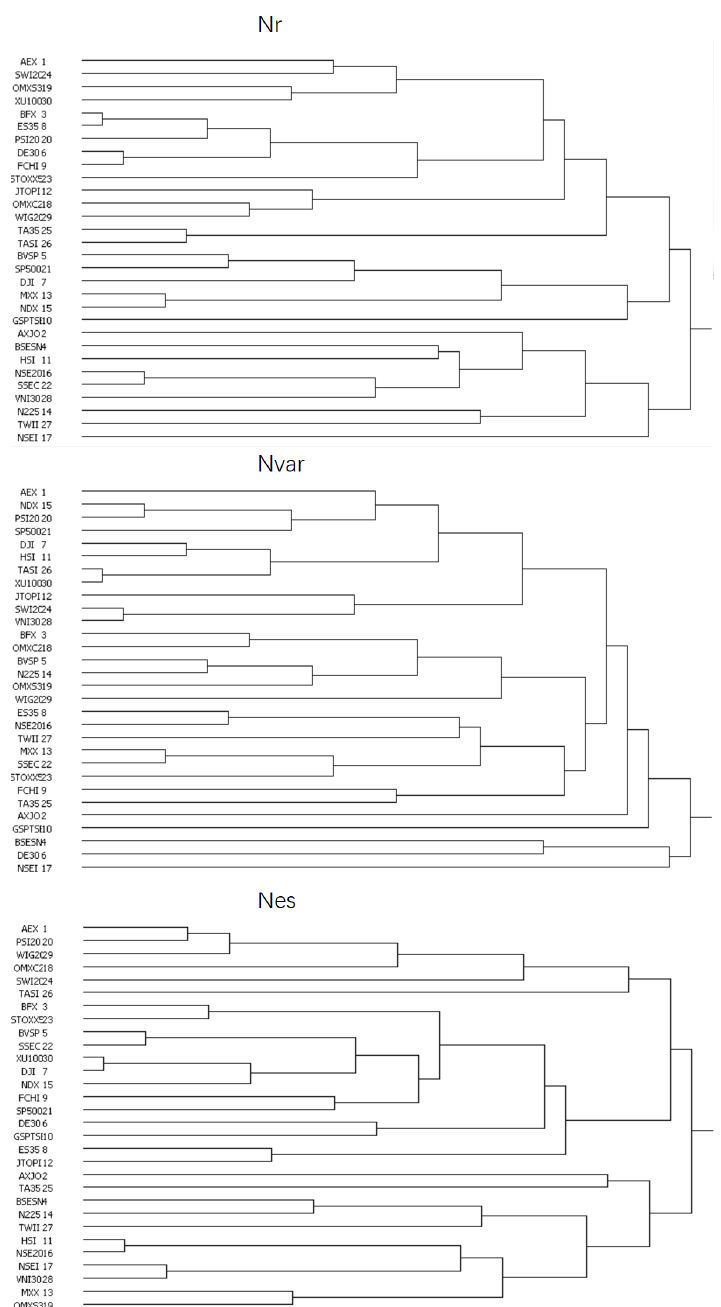
Figure 6. Tree Diagrams of Hierarchical Clusters for Networks N r , N var and N es 2